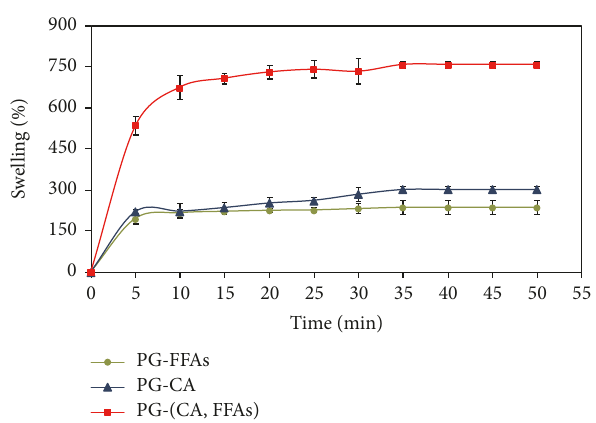
Figure 6: Swelling behavior of treatments PG-FFAs ( e ), PG-CA ( 󳵳 ), and PG-(CA, FFAs) ( ◼ ). Measurements were taken at 20 ∘ C and pH 5 using (1).